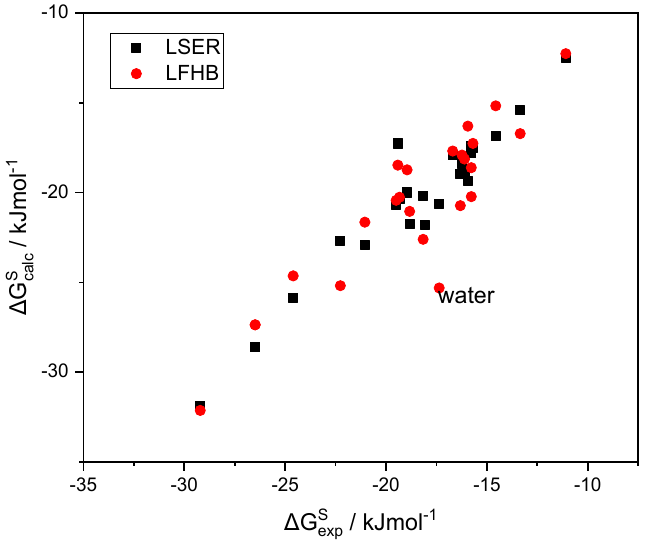
Figure 3. The LSER estimations of the solvation free energy of various solutes in 1-octanol, as a function of the corresponding experimental data [49].